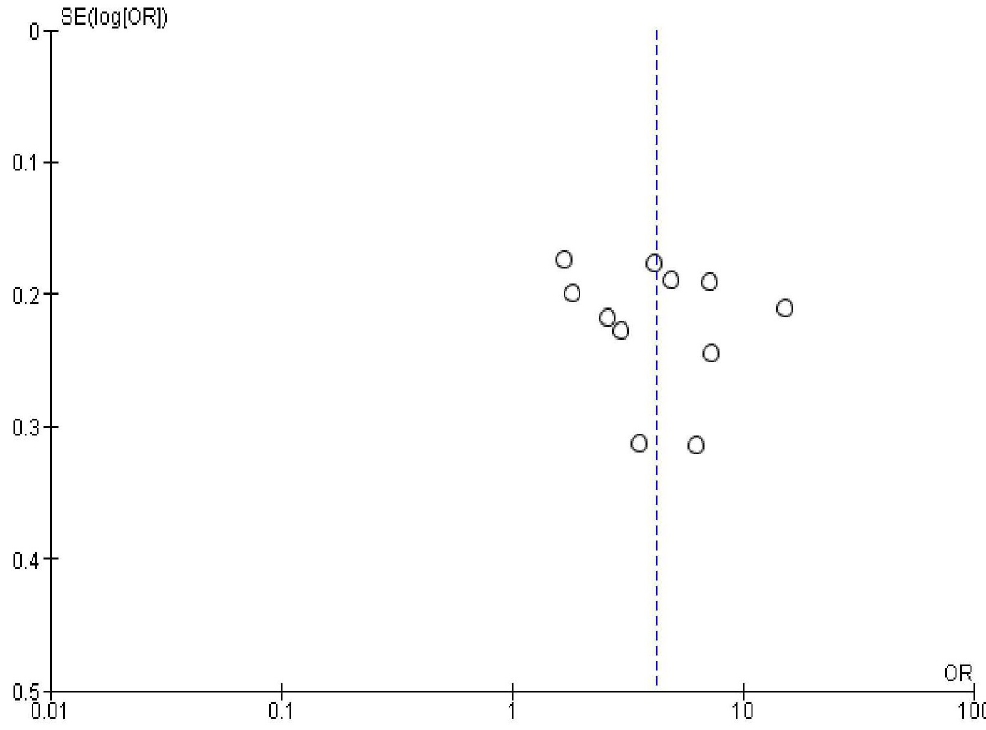
Fig 22. Publication bias on having PNC follow up.